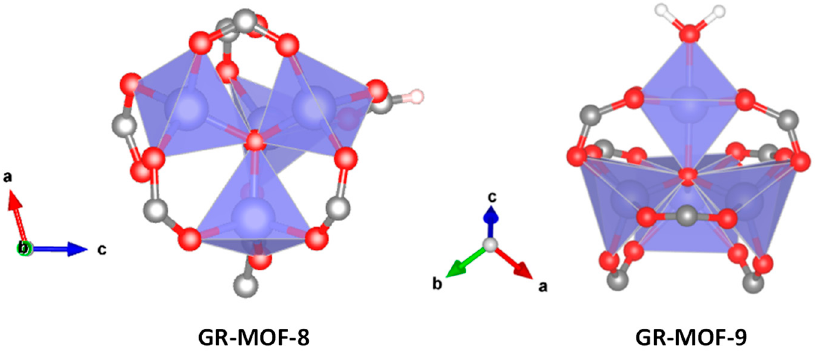
Figure 2. Schematic view of the Zn tetra-tetrahedra nodes of GR-MOF-8 and 9. Zn, C, O and H are represented in blue, grey, red and white,